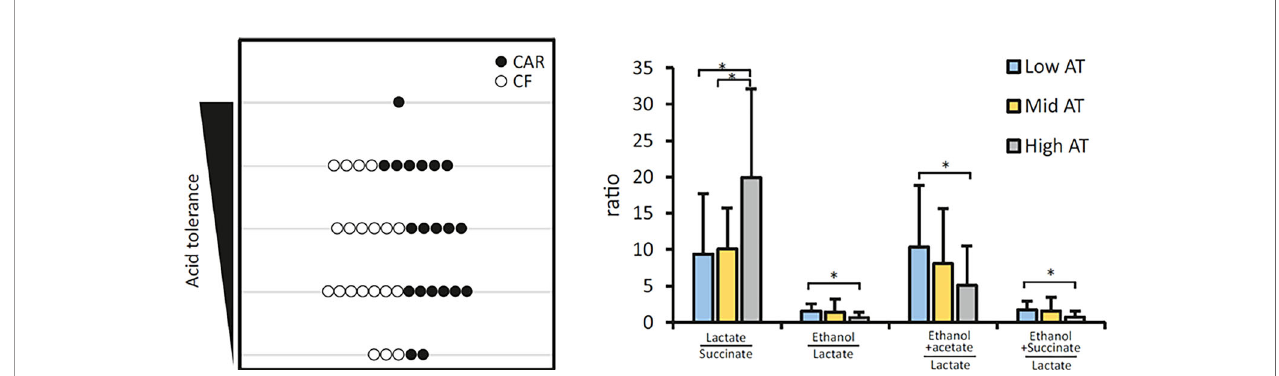
FIGURE 4 | Acid Tolerance (AT) of dental plaque from adolescents. The left panel represents the distribution of caries-experienced (CAR) and caries-free (CF) individuals in different acid tolerance groups. Individuals are assigned to an acid tolerance group from 1 to 5, being 1 the lowest and 5 the highest acid tolerance detected in dental plaque samples exposed to high sugar conditions. Bar graphs on the right panel represent the means of several metabolite ratios for Low (AT levels 1-2), Intermediate (AT level 3) and High (AT levels 4-5) acid tolerance groups. Statistically signi fi cant differences are indicated by an asterisk. Metabolite pro fi les in plaque supernatants exposed to high sugar conditions were obtained by NMR analysis.